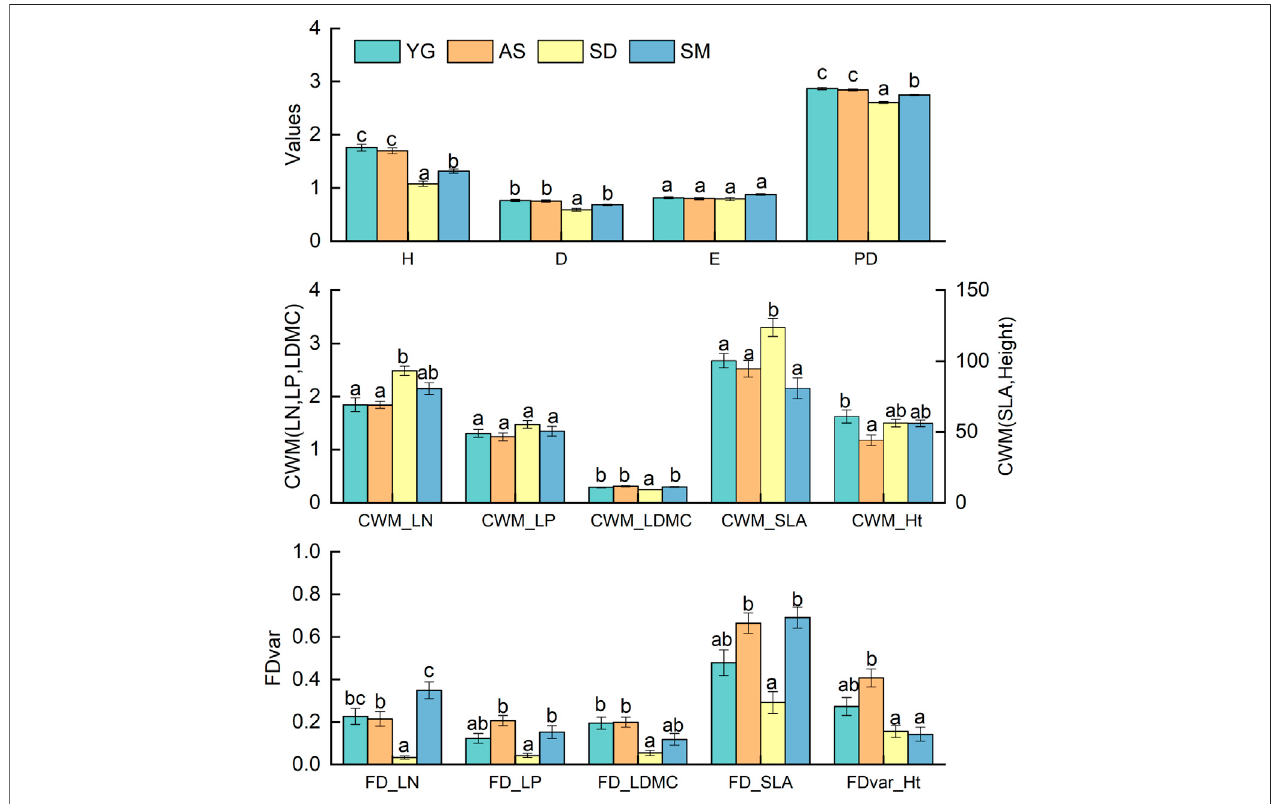
FIGURE 3 | The means of diversity indices among the sites. SLA, speci fi c leaf area; LDMC, leaf dry matter content; LN, leaf nitrogen content; LP, leaf phosphorus content;Ht,plantheight.Theinsertedbarchartsshowedthedifferencesintheindicesamongthreesites.Differentlettersindicatesigni fi cantdifferencesat p < 0.05.Error bars are standard error (SE).